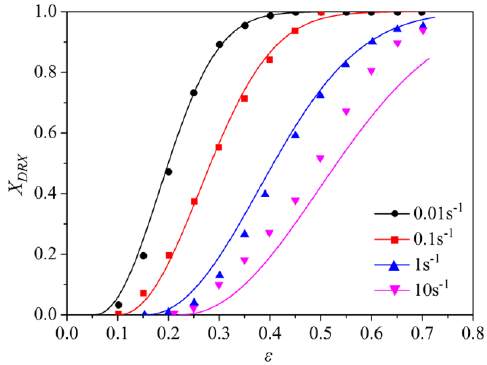
Figure 8. A comparison of calculated and measured values of the dynamic recrystallization percentage.